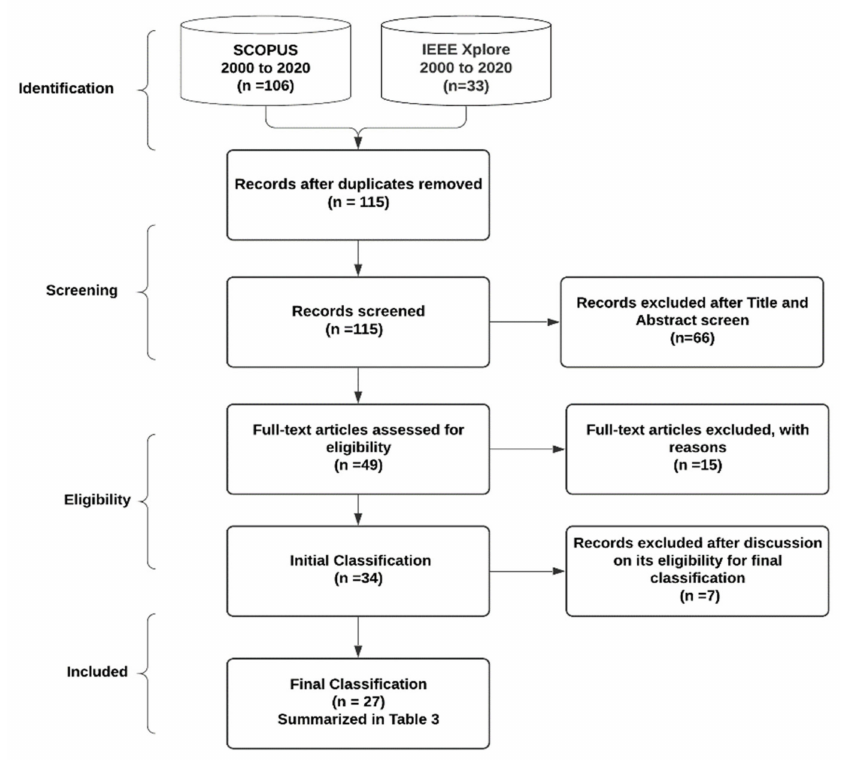
Figure 6. Phase III: Text Mining and Apparel Industry research papers selection